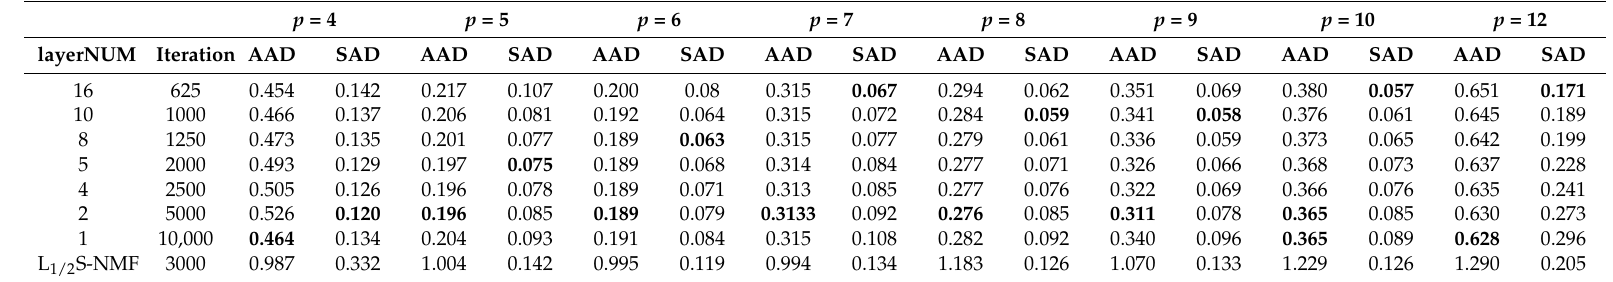
Table 1. Comparison of SAD, AAD for HWSU versus layer number and endmember